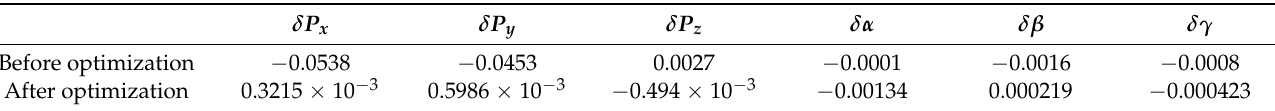
Table 1. Comparison of pose errors before and after WOA algorithm optimization.